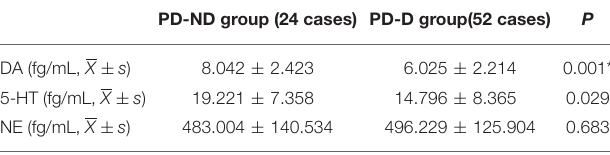
TABLE 5 | Correlation of HAMD scores with the levels of neurotransmitters in CSF from PD patients. R P DA (fg/ml) − 0.278 0.015* 0.056